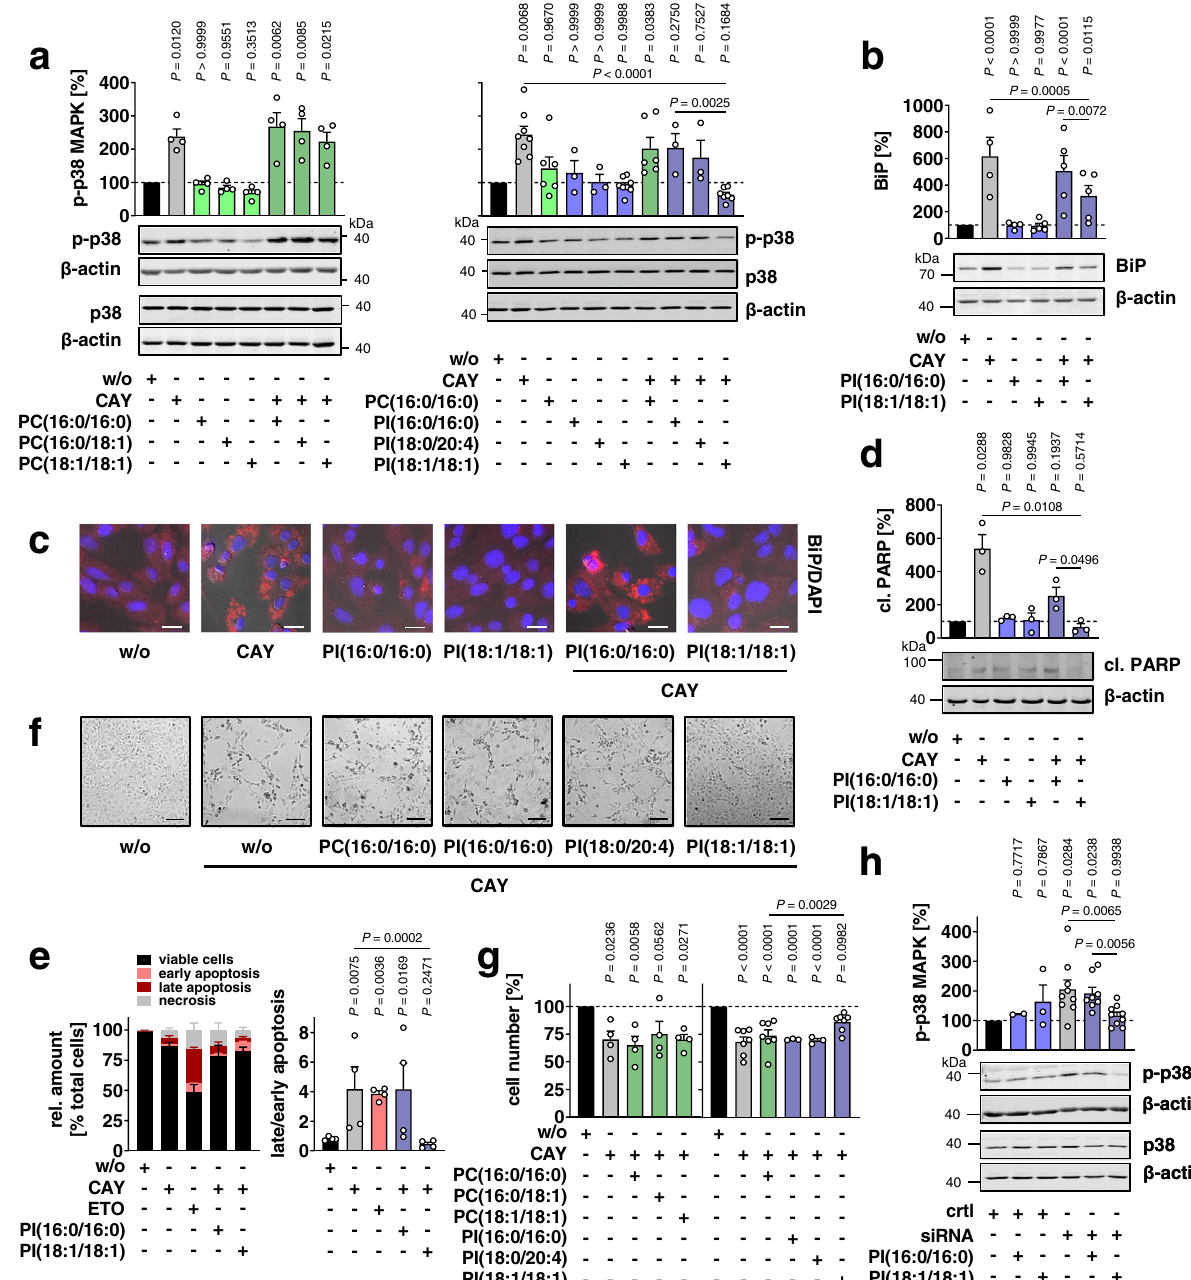
All phospholipids were ef fi ciently taken up by fi broblasts